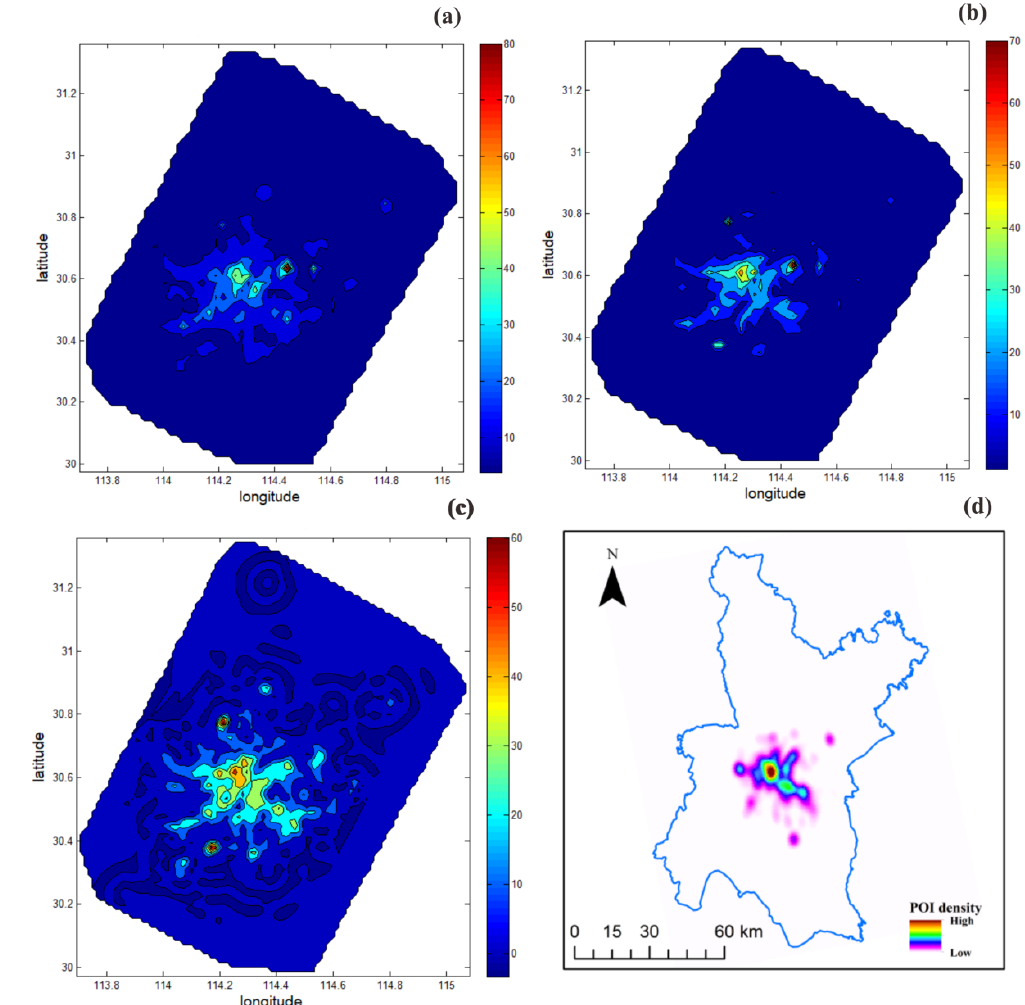
Figure 11. Urban area hotspots in Wuhan during 2013–2018 identified by SVM regression method: ( a ) urban area hotspots in 2013; ( b ) urban area hotspots in 2015; ( c ) urban area hotspots in 2018; ( d ) spatial distribution of POI density in 2018.